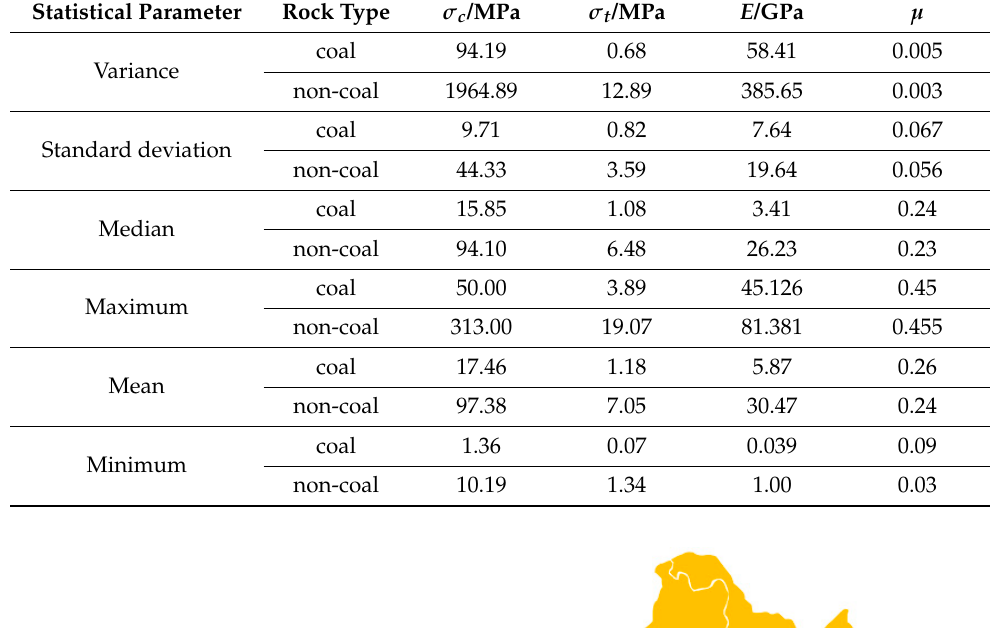
Table 1. Statistical parameters of the basic mechanical parameters of coals and non-coal rocks.